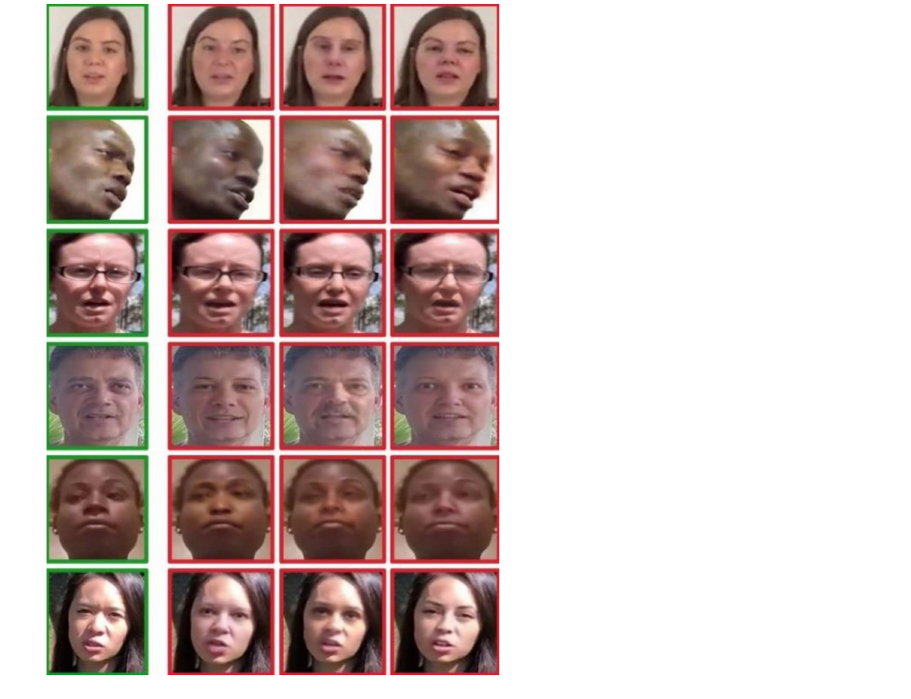
Figure 9. Samples from DeepFakeDetectionChallenge-Preview (DFDC-P) dataset where green boxes are real faces and red are